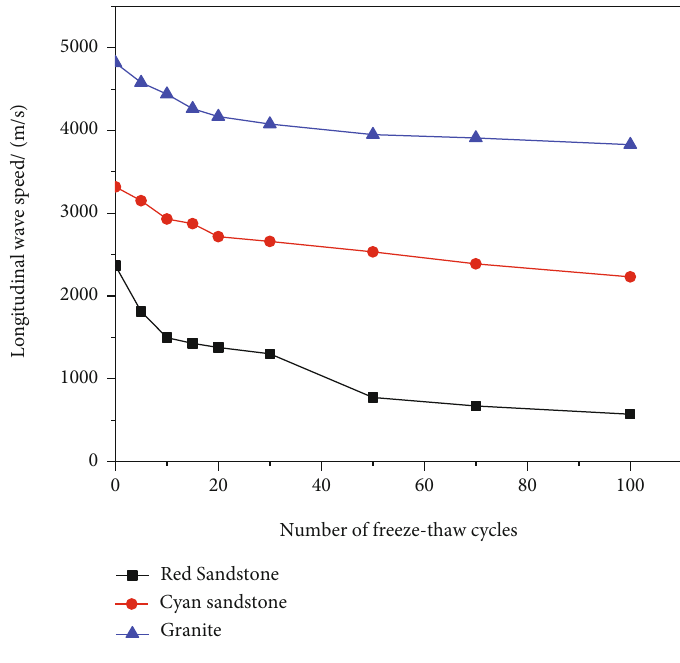
Figure 6: Wave speed variation